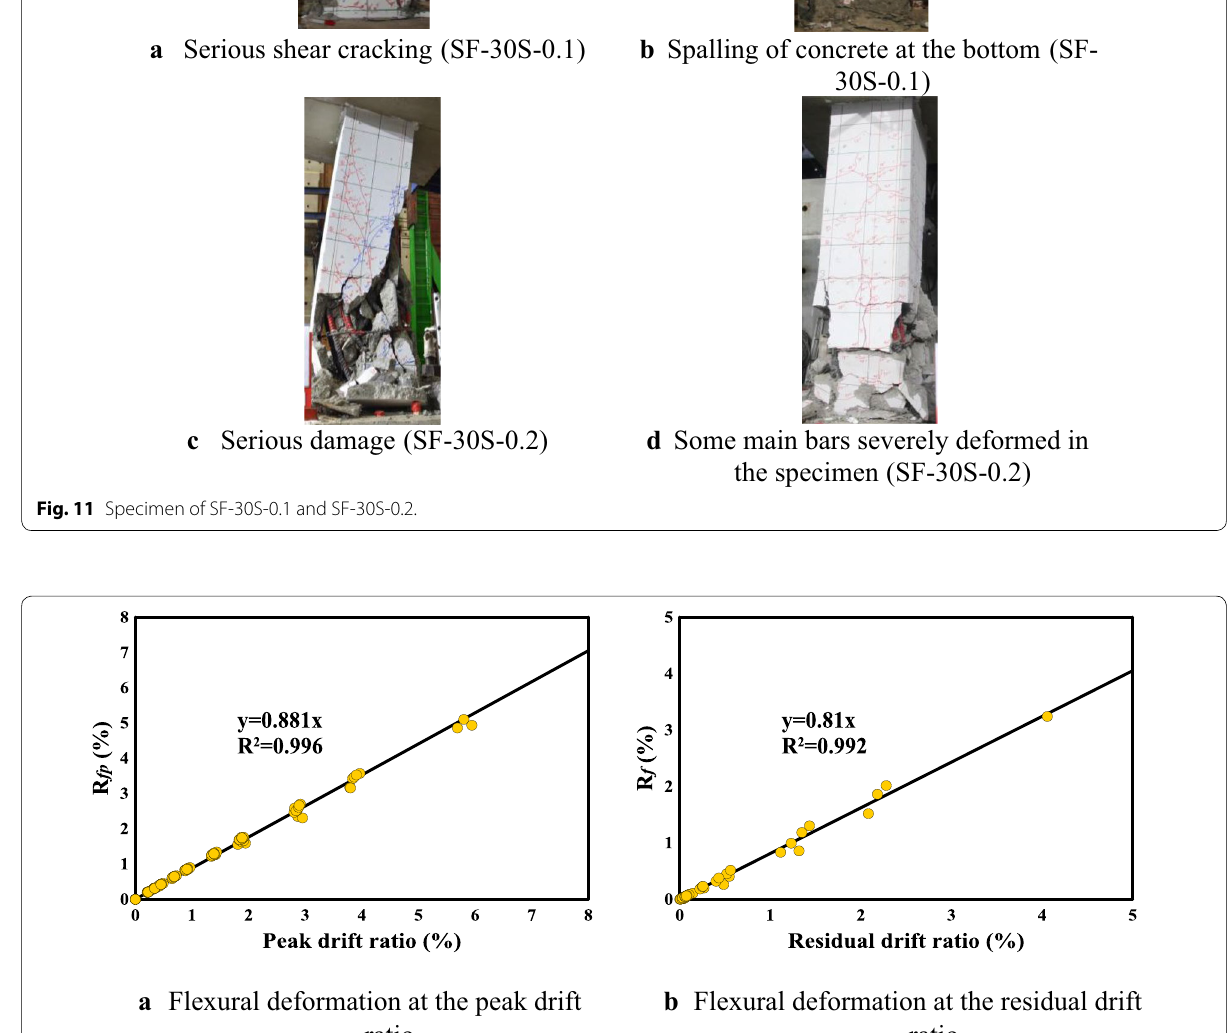
Fig. 12 Flexural deformation of specimens under the